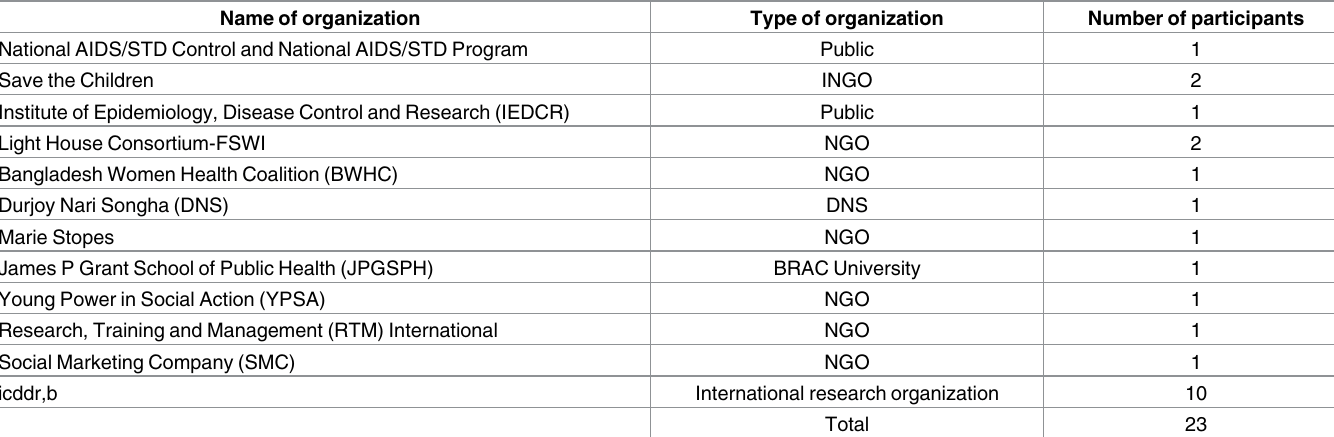
Table 1. Number of participants by type of